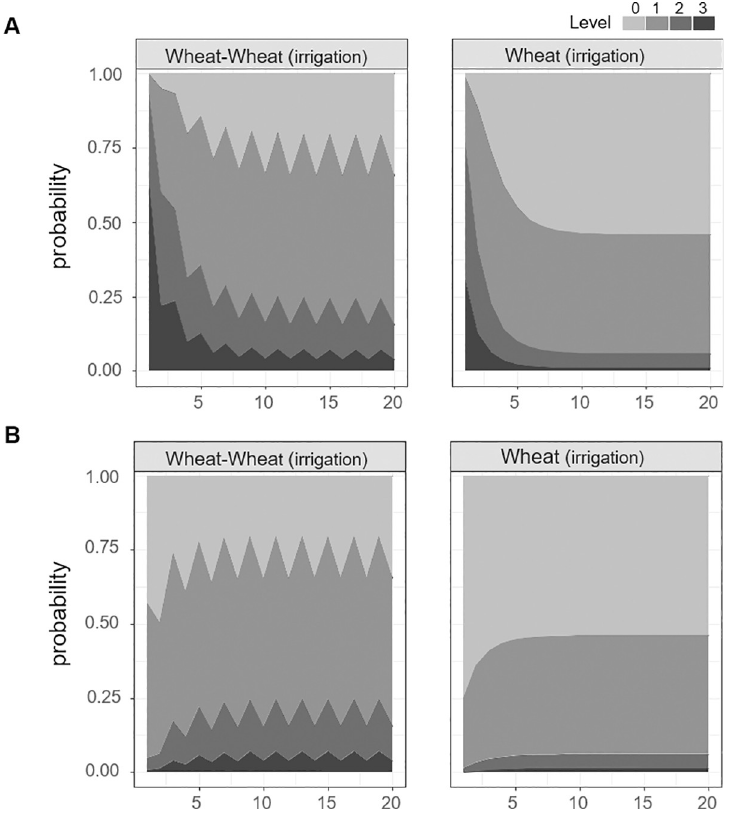
Fig 4. Projected state probabilities under repeated cycles of “wheat-wheat with summer irrigation” and “wheat with summer irrigation”. A) Initial coverage was set at level 0 ( A . fatua is absent) and B) level 3 (high A . fatua